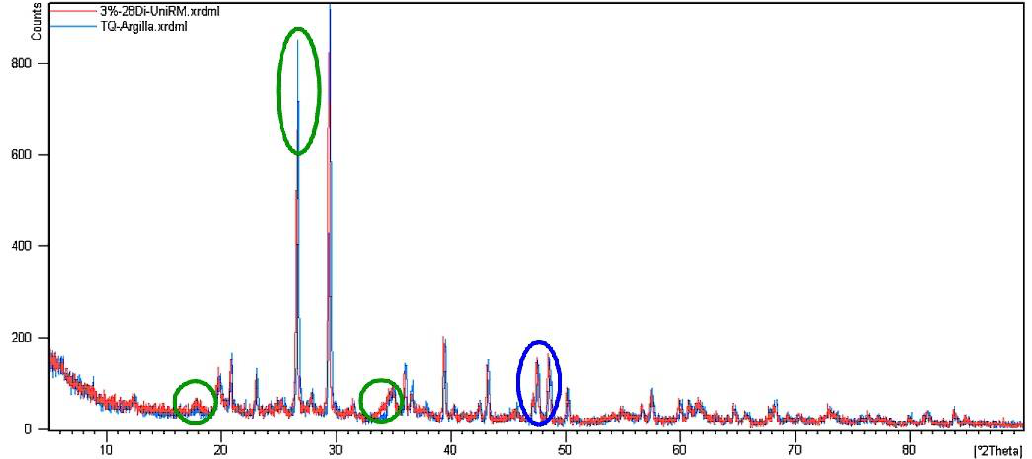
Figure 9. Overlay of TQ3 diffractogram at 28 d (red) and TQ0 diffractogram (blue).